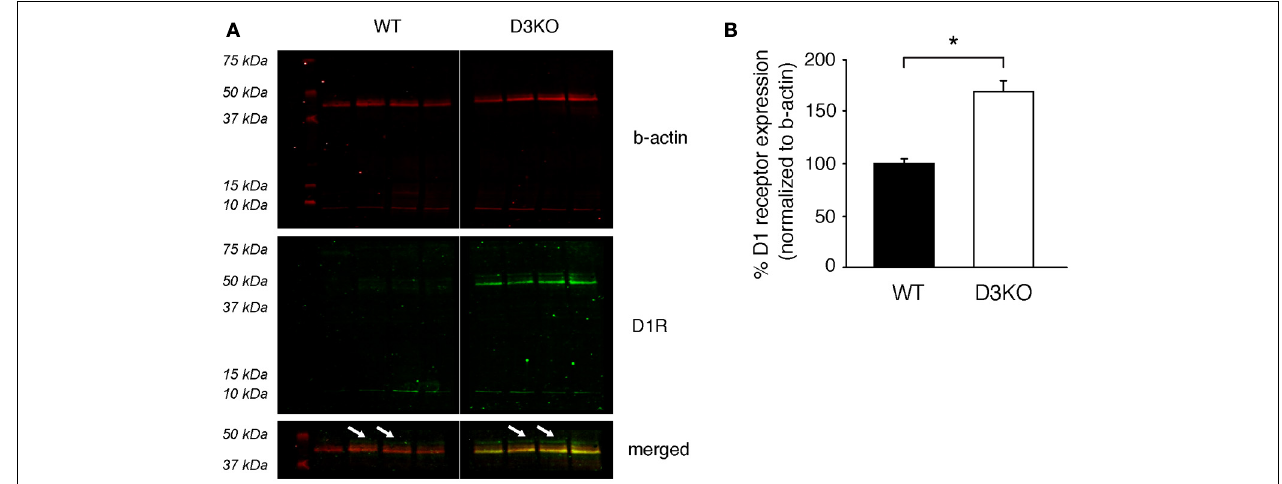
FIGURE 6 | Protein expression levels of the dopamine D1 receptor in lumbar spinal cord. (A) ß-actin (top panels, red), D1R (middle panels, green), and merged images of the 37–50kDa band of interest (bottom panels) of the same blot. Note that ß-actin expression is similar in WT and D3KO. In contrast, the D1R antibody recognizes a strong signal at the 42kDa